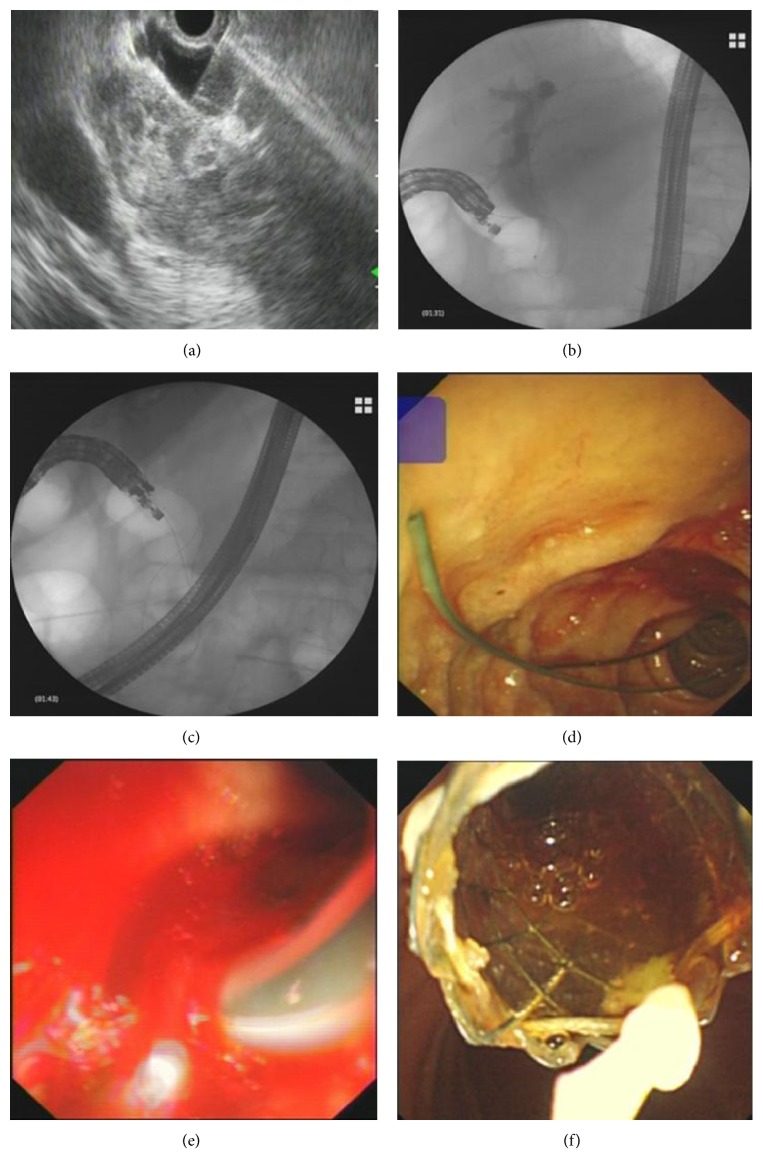
Endoscopic ultrasound-guided rendezvous technique. Under real-time EUS guidance, the dilated bile duct was punctured and a cholangiogram was obtained (a and b). A guidewire was advanced in an antegrade direction through the site of stenosis and across the papilla (c and d). Biliary cannulation was performed in the usual manner over the guidewire (e). Finally, an uncovered self-expandable metal stent was deployed for biliary drainage (f).